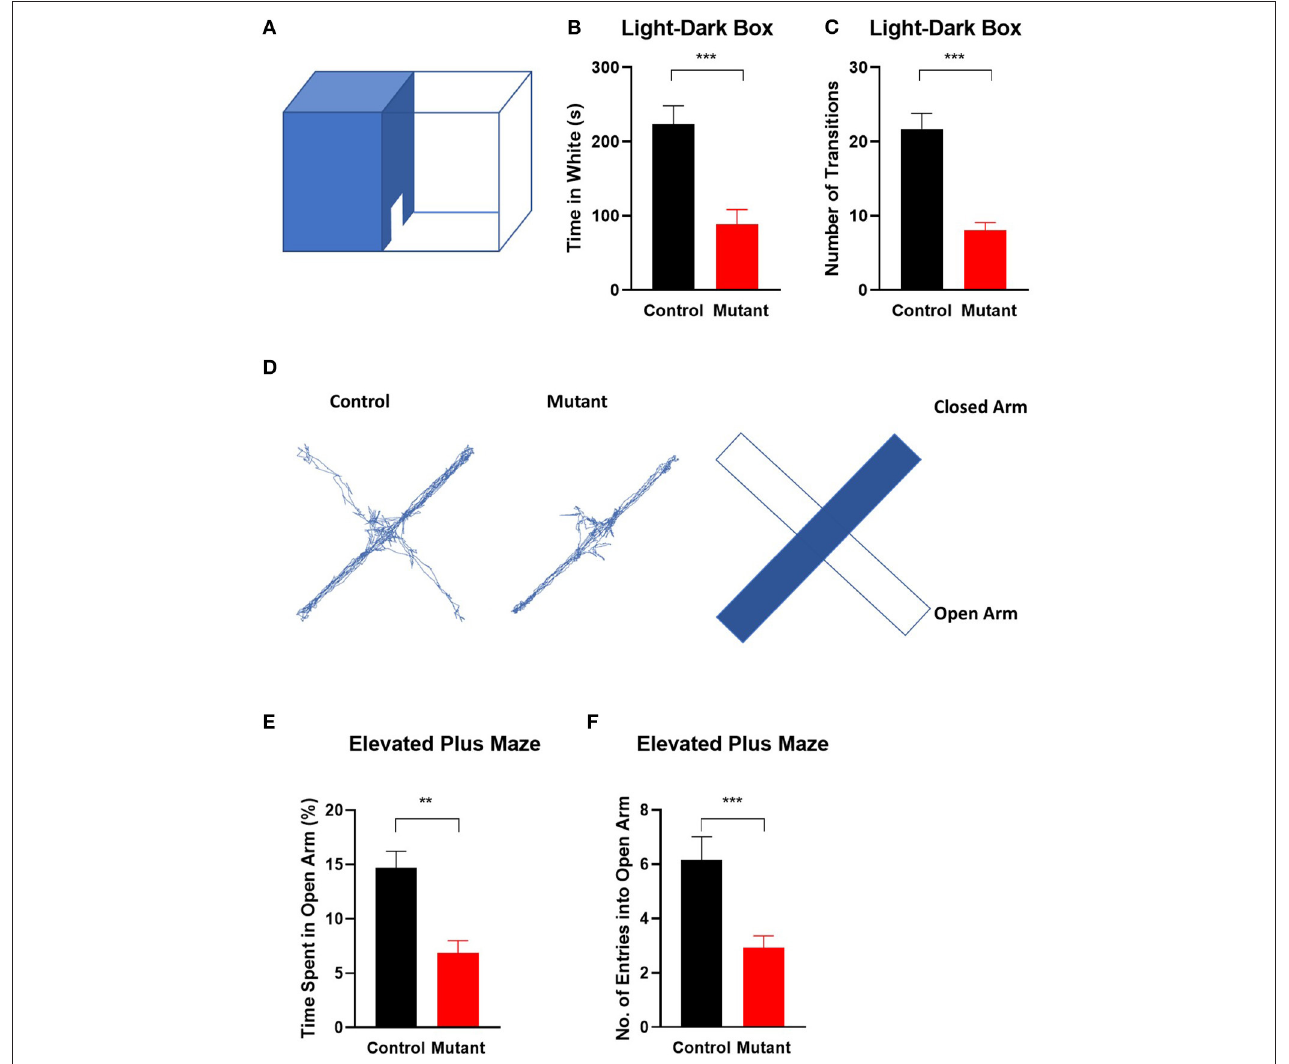
FIGURE 4 | Elevation of anxiety in Scn8a PC mutant mice. (A) Schematic of light-dark transition box. In the light–dark preference test, PC Scn8a mutant mice spent significantly less time in the light room (B) and entered it less often than controls (C) . ( n = 15 for control and n = 13 for mutant). (D) Representative elevated plus maze tracking plots and diagram illustrates locations of open and closed arms of the maze. Mutant mice demonstrated decreased time spent in the open arms (E) , and less frequently enter into the open arms (F) of the elevated plus maze (Control: n = 13 Mutant: n = 16). ** P < 0.01, *** P < 0.001. All P -values by the Student’s unpaired t